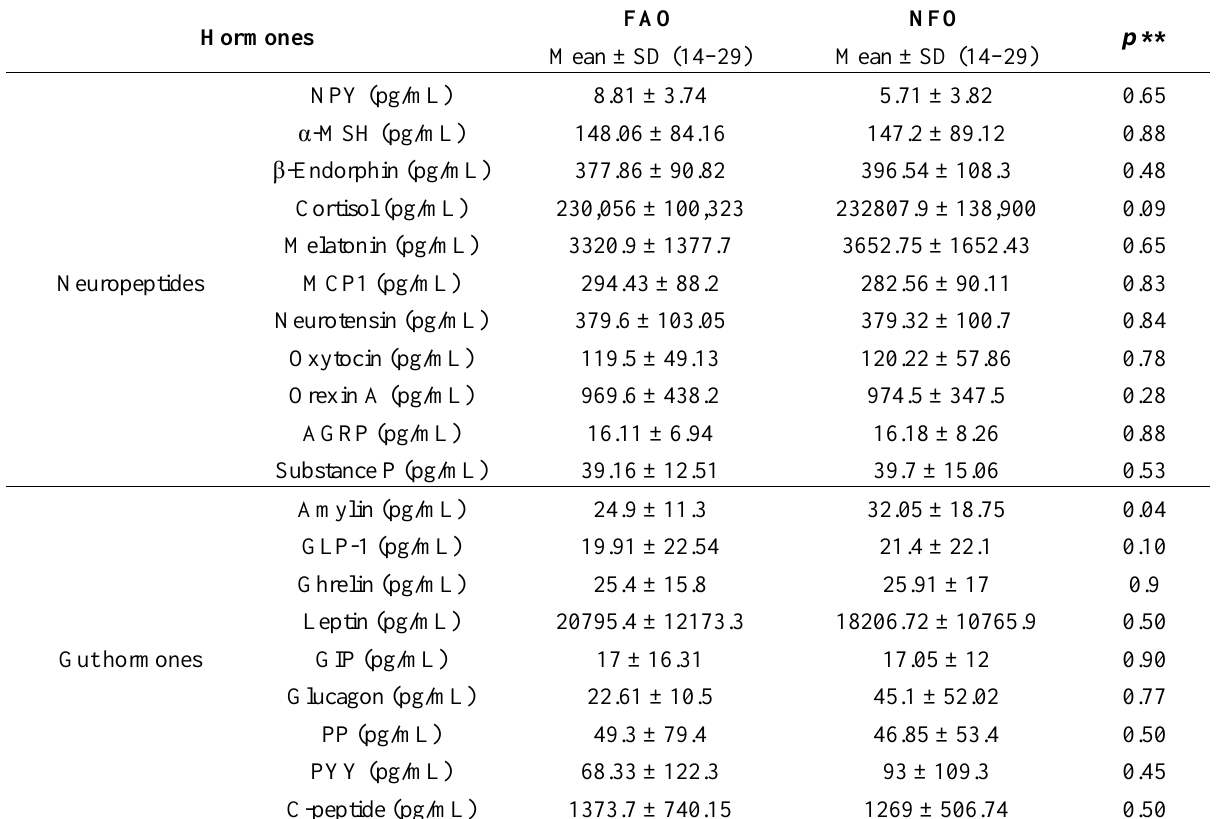
Table 2. Hormonal and neuropeptide characteristics in FAO and NFO *.